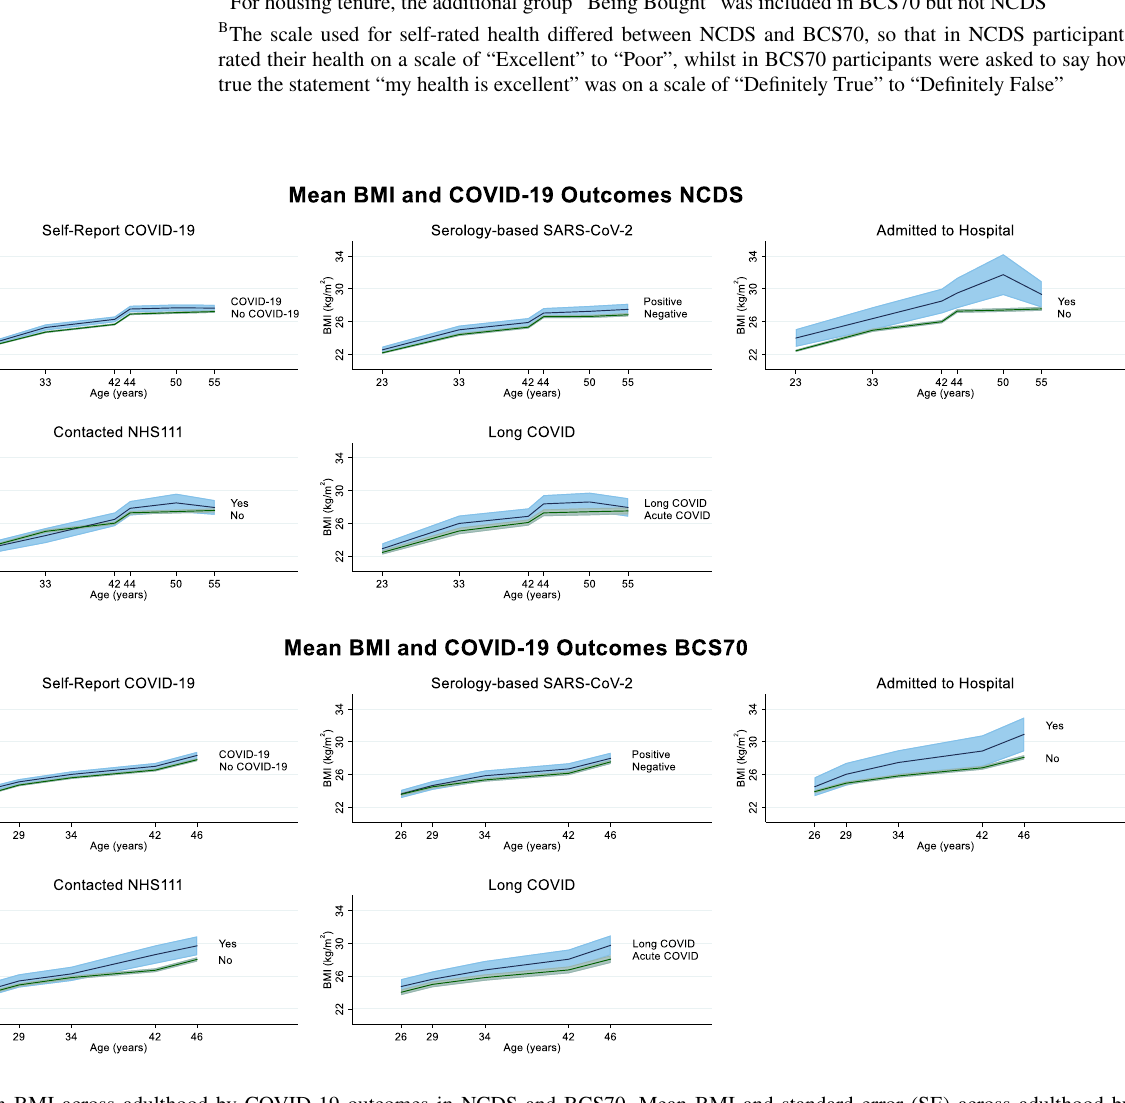
Fig. 1 Mean BMI across adulthood by COVID-19 outcomes in NCDS and BCS70. Mean BMI and standard error (SE) across adulthood by COVID-19 outcomes age 62 in NCDS and age 50 in